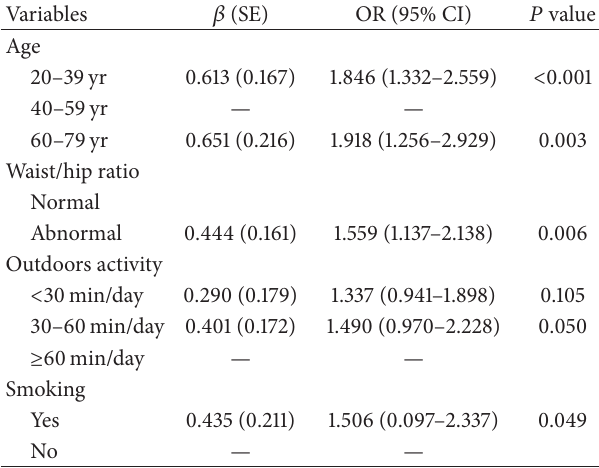
Table 4: Multiple factor logistic regression of low serum 25(OH)D of less than 30ng/mL.